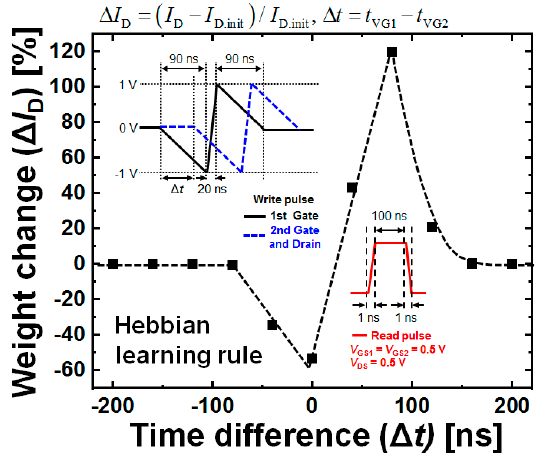
Figure 8. Array architecture for the artificial spike neural network (SNN) based on the proposed SFGST device with the full accommodation of the developed bias schemes.